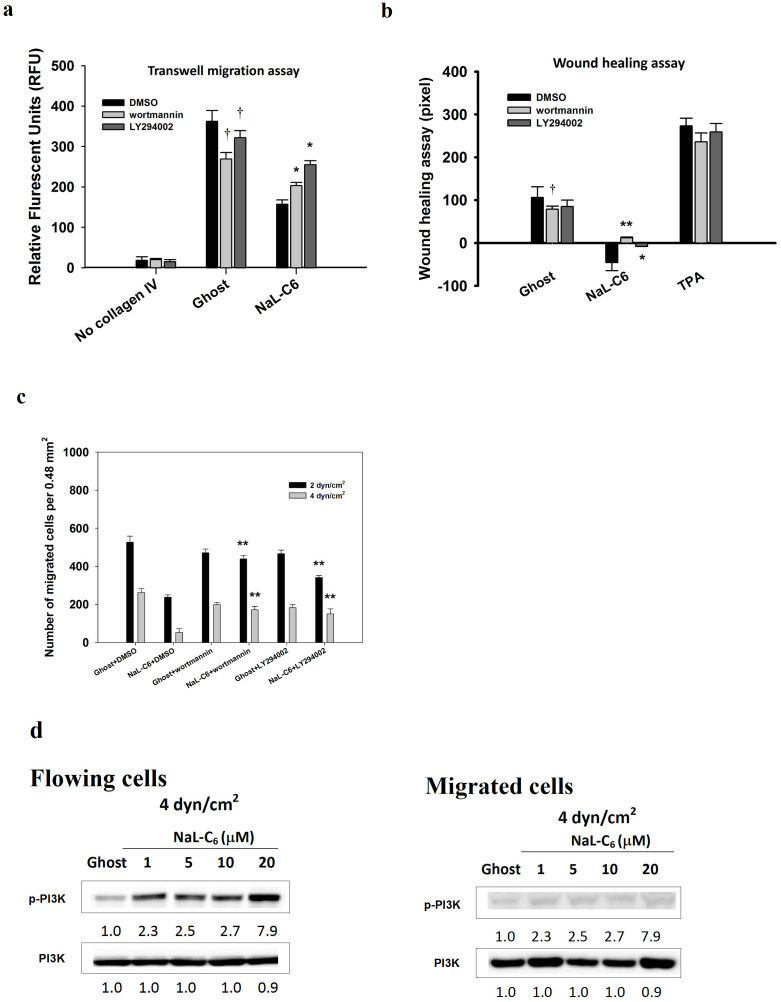
PI3K activation was required for NaL-C6-suppressed cell static migration and transmigration in flow.(a–c) MDA-MB-231cells were incubated with DMSO, 500 nM wortmannin or 10 μM LY294002 for 30 min before being treated with ghost or 20 μM C6-ceramide nanoliposomes or 200 nM TPA for 30 min. The migration of treated MDA-MB-231cells was assessed by transwell migration assay (a), wound healing assay (b) and flow migration assay (c). Results were expressed as mean ± SEM. n = three replicates. (a) *p < 0.05 compared with NaL-C6+DMSO; †p < 0.05 compared with NaL-C6+DMSO. (b) *p < 0.05, **p < 0.01 compared with NaL-C6+DMSO; †p < 0.05 compared with ghost+DMSO. (c) **p < 0.01 compared with NaL-C6+DMSO.(d) The lack of migratory potency of MDA-MB-231 cells was correlated with phosphorylation of PI3K. MDA-MB-231 cells were treated with various doses of C6-ceramide nanoliposomes or ghost nanoliposomes for 30 min prior to flow migration experiments. After flow migration at 4 dyn/cm2 for 4 hr, flowing cells were collected from the circulation loop and migrated cells were trypsinzed. Flowing and migrated cells were subjected to western blotting analysis of phospho-PI3K and total PI3K. Data represent three replicates.